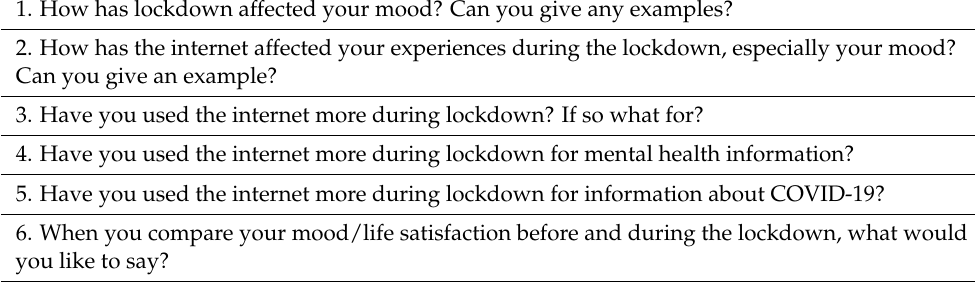
Table 2. Qualitative